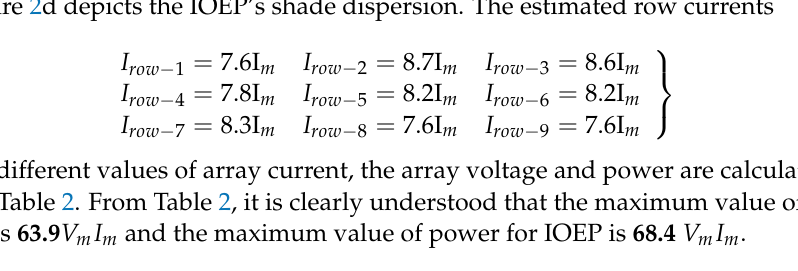
Table 2. GMPP for 9 × 9 PV array for Case-1 (Top-Left)